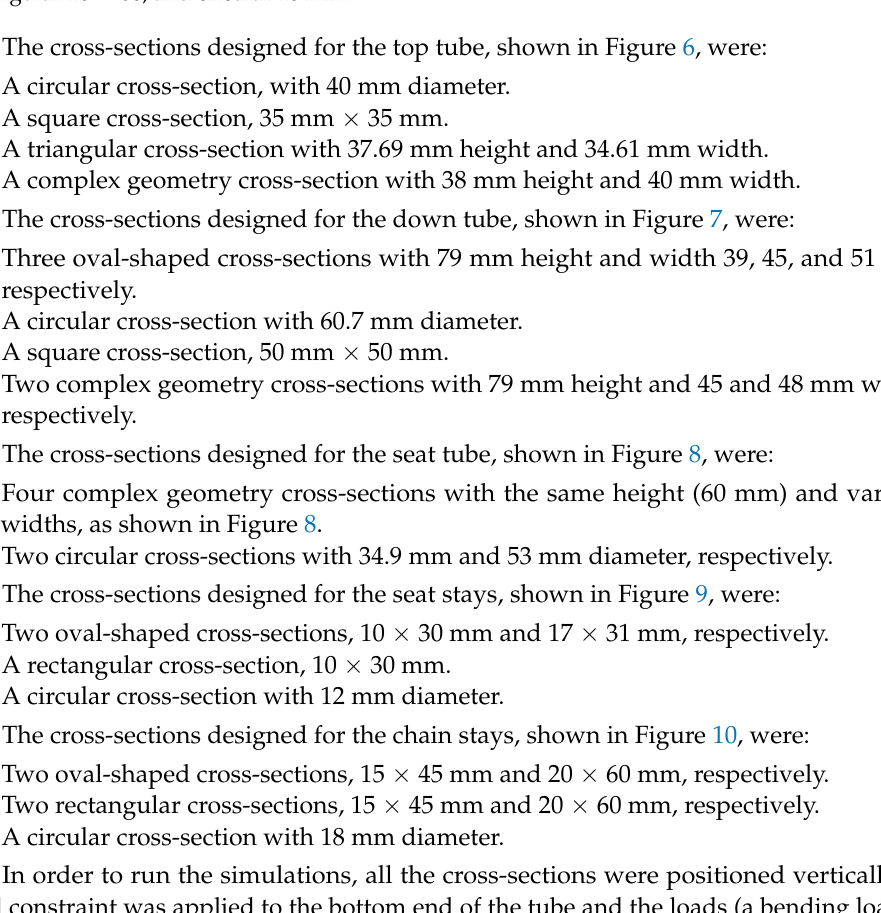
Figure 10. Chain stay cross-sections from left to right: oval 15 × 45, oval 20 × 60, rectangular 15 × 45, rectangular 20 × 60, and circular 18